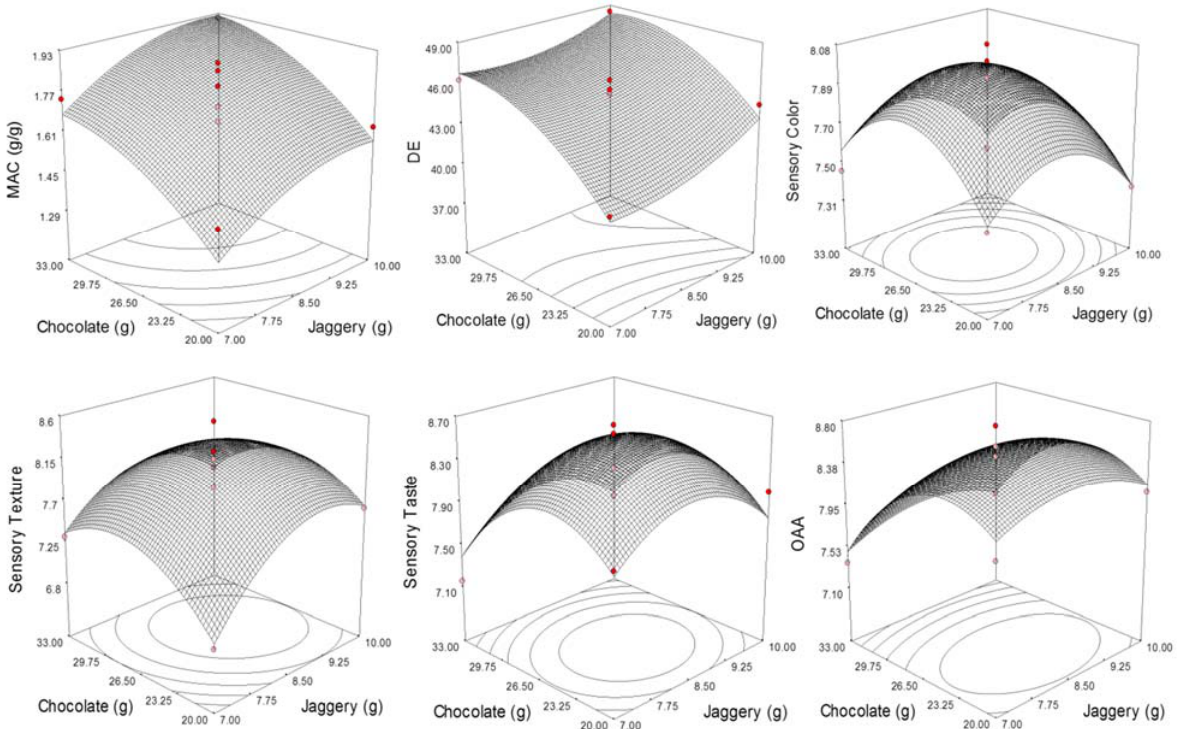
Figure 2. Functional and sensory responses as affected by the levels of jaggery and chocolate.